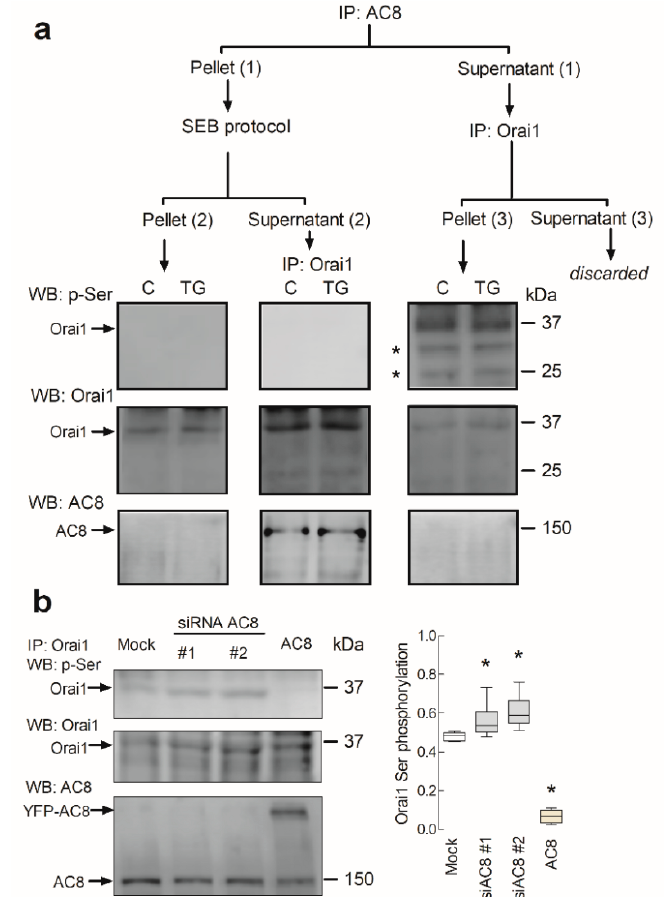
Figure 7. AC8 modulates Orai1 serine phosphorylation. ( a ) Phosphorylation of AC8-associated and -independent Orai1 at Ser-27 and -30. MDA-MB-231 cells were stimulated with 1 µM TG or the vehicle (C) and lysed 1 min later. Whole-cell lysates were immunoprecipitated (IP) with anti-AC8 antibody, yielding pellet (1) and supernatant (1). The proteins of pellet (1) were eluted with soft elution buffer (SEB). This step resulted in pellet (2) and supernatant (2). Pellet (2) was subjected to 10% SDS-PAGE and subsequent Western blotting with anti-phosphoserine antibody. Supernatant (2) was immunoprecipitated with anti-Orai1 antibody, followed by Western blotting with anti-phosphoserine antibody. On the other hand, supernatant (1) was immunoprecipitated with anti-Orai1 antibody, leading to pellet (3) and supernatant (3) that was discarded. Pellet (3) was subjected to 10% SDS-PAGE and subsequent Western blotting with specific anti-phosphoserine antibody, as indicated. Membranes were reprobed with anti-Orai1 and anti-AC8 antibodies for protein loading control. The panels show results from one experiment representative of five others. Molecular masses indicated on the right were determined using molecular-mass markers run in the same gel; * nonspecific bands. ( b ) MDA-MB-231 cells were transfected with YFP-AC8 (AC8) transfection plasmid, siAC8#1, siAC8#2